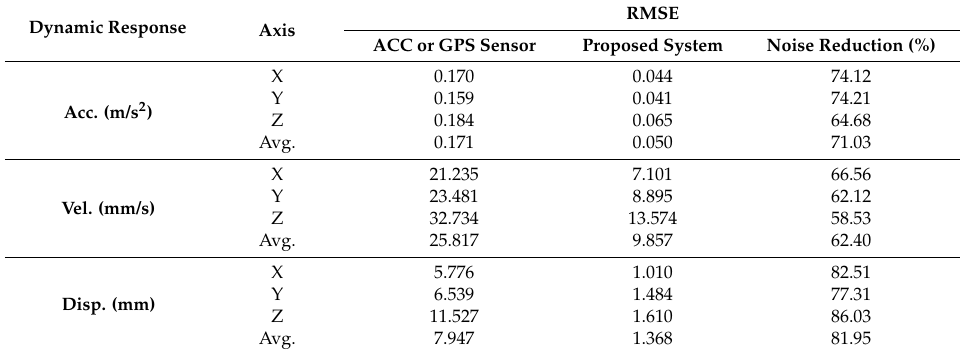
Table 2. The effect of the proposed measurement system on noise reduction in X, Y and Z axes. Dynamic Response Axis